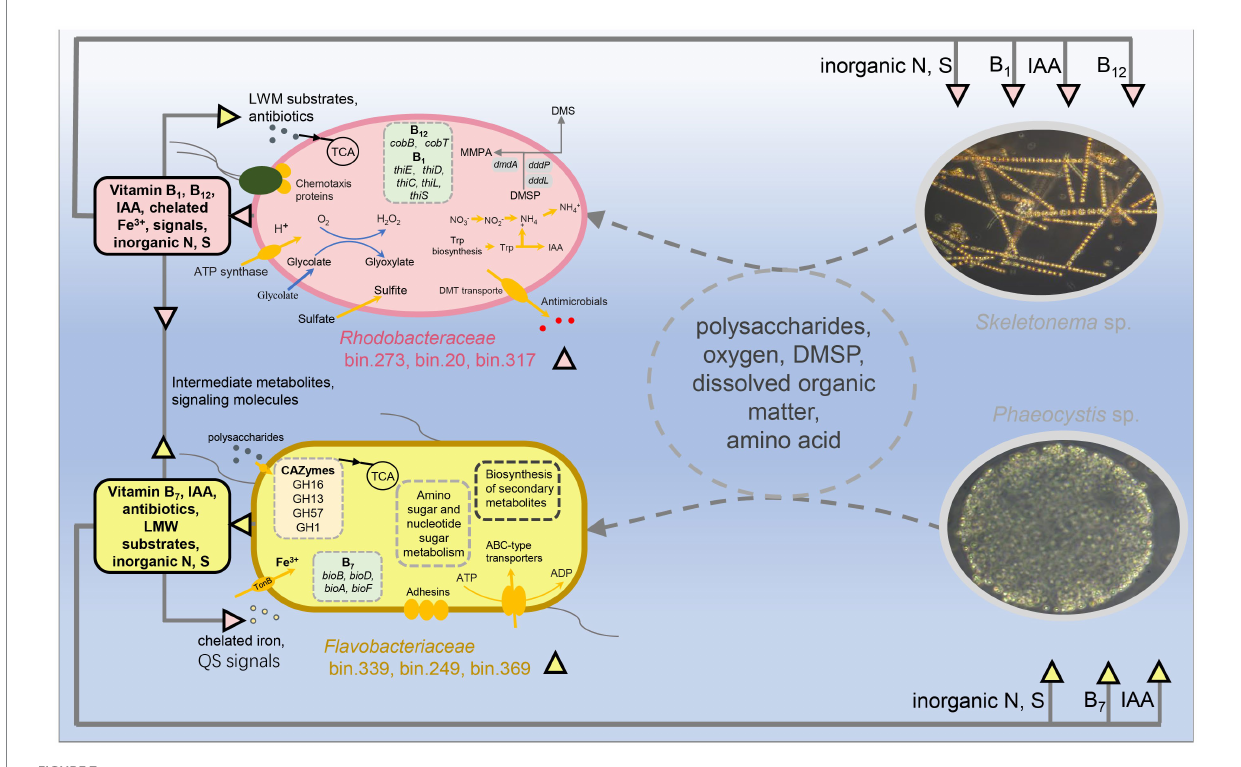
FIGURE 7 Potential metabolic interactions between the algae blooms and the reconstructed genomes of the two bacterial lineages, Flavobacteriaceae and Rhodobacteraceae . Colored triangles indicate metabolites sourced from Flavobacteriaceae (orange) and Rhodobacteraceae (pink), while arrow directions indicate predicted